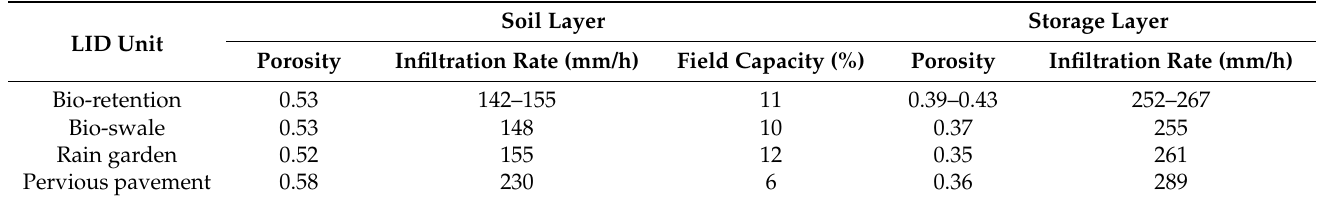
Table 4. Main parameter values of LID units calibrated in SWMM.